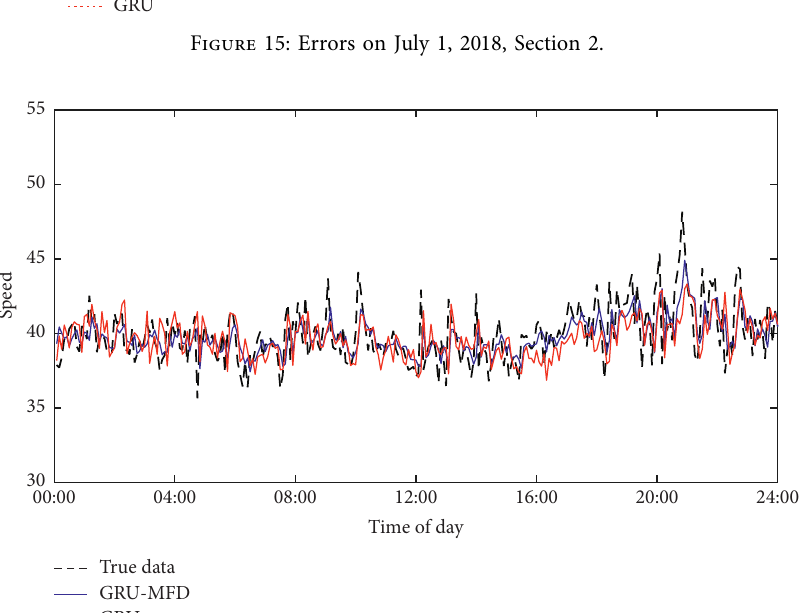
Figure 15: Errors on July 1, 2018, Section 2.